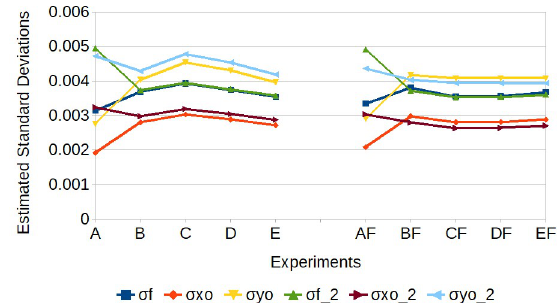
Table 7. Results obtained with the images cropped with a fixed value for the crops origins: estimated values for the IOPs of images of the infrared band, estimated standard deviations and differences with respect to the average value of visible bands.